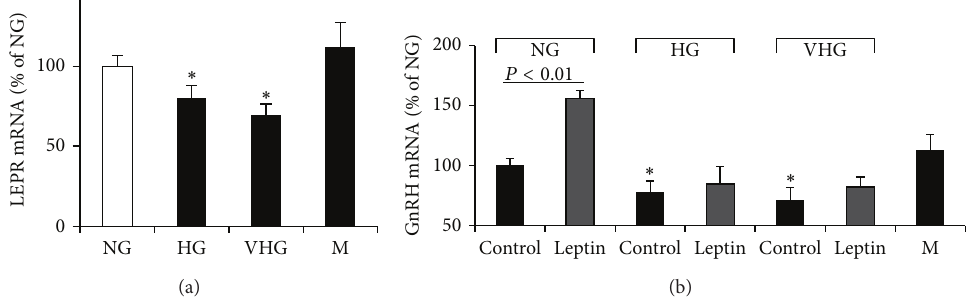
Figure 3: Effect of high glucose on leptin signaling in FNCB4 cells. (a) Quantitative RT-PCR analysis of LEPR mRNA expression in FNC-B4 cells exposed to normal (NG, 5mM), high (HG, 22 mM), and very high (VHG, 40mM) glucose concentration or mannitol (M, 22mM) for 24 hours. (b) Effect of leptin (1 nM, 24 hours) on GnRH mRNA expression in FNC-B4 cells exposed to the different glucose concentrations (NG, HG, and VHG) or mannitol (M, 22mM). Results were calculated according to the comparative Ct method, using 18S rRNA subunit as the reference gene for normalization and were obtained from at least three separate experiments, each performed in triplicate. Data are reported as mean ± SEM and are expressed in % of NG. ∗ 𝑃 < 0.05 ; ∗∗ 𝑃 < 0.01 versus